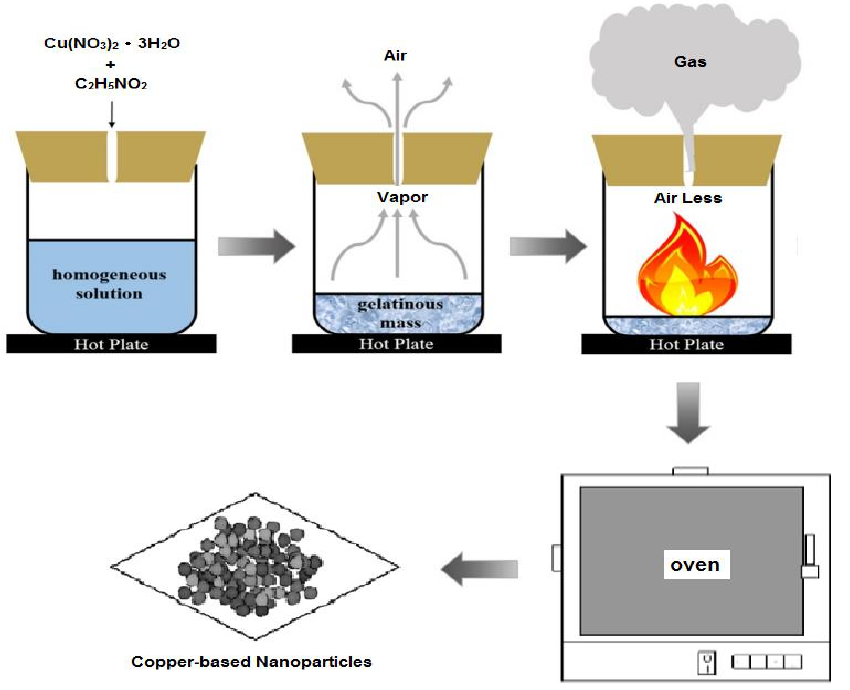
Figure 8. Schematic illustration of combustion synthesis for the copper G/N reaction system.